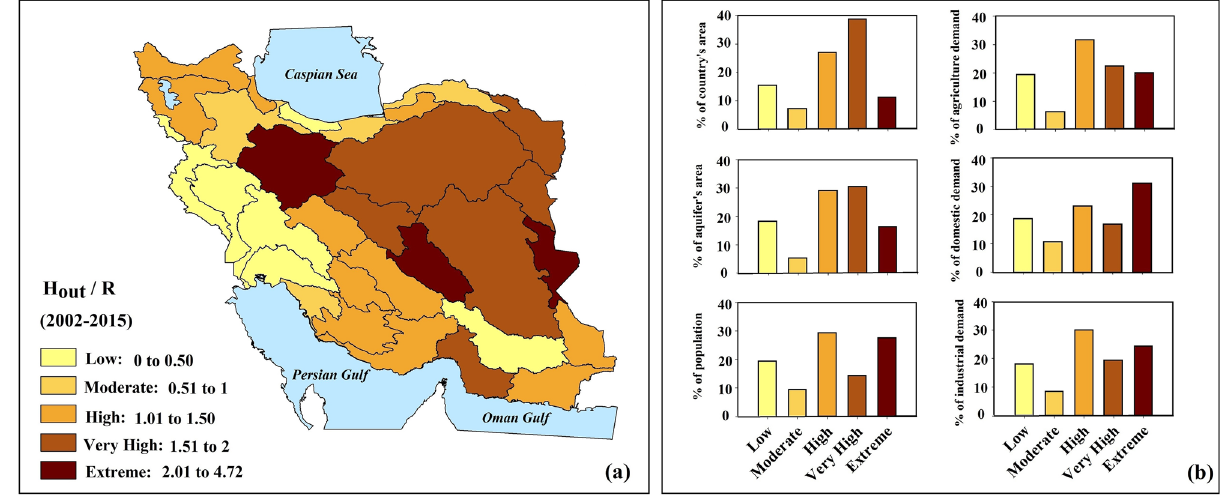
Figure 5. ( a ) The rate of groundwater overdraft during 2002–2015 in Iran; and ( b ) the percentage of population, land area, aquifer area and water demands in each overdraft category (This figure is created using ArcGIS